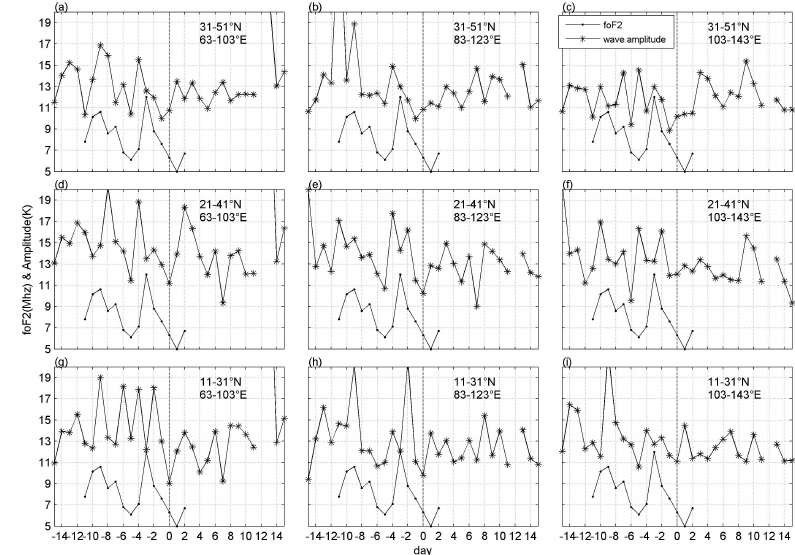
Fig. 12. The same as for Fig. 10 but for the Wenchuan earthquake.